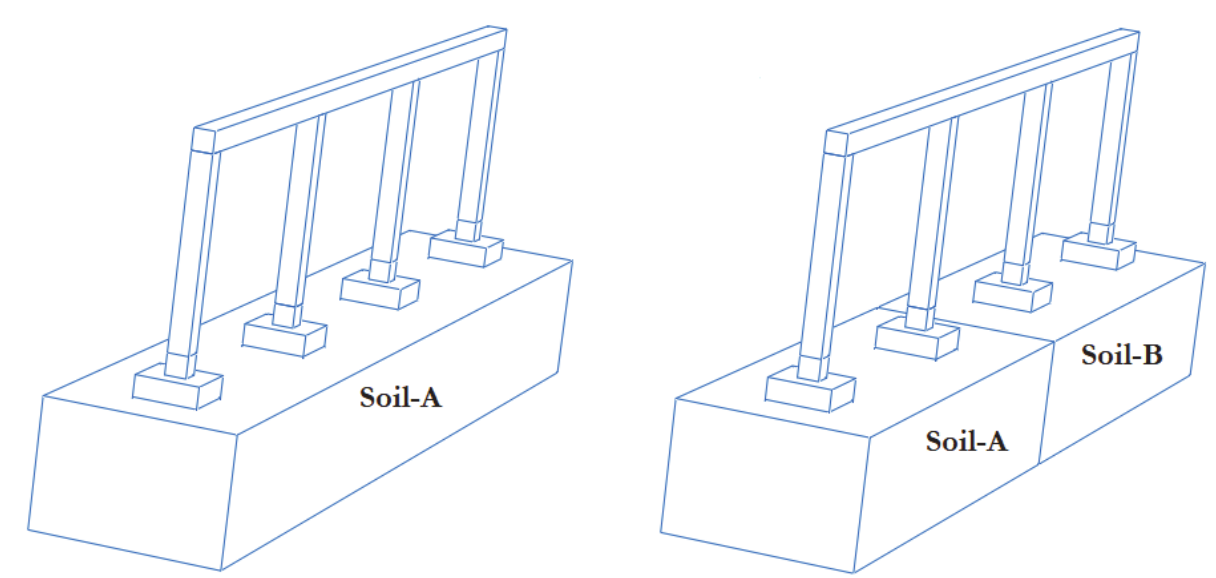
Figure 2: The soil configuration and timber frame archetype used in the numerical simulation.